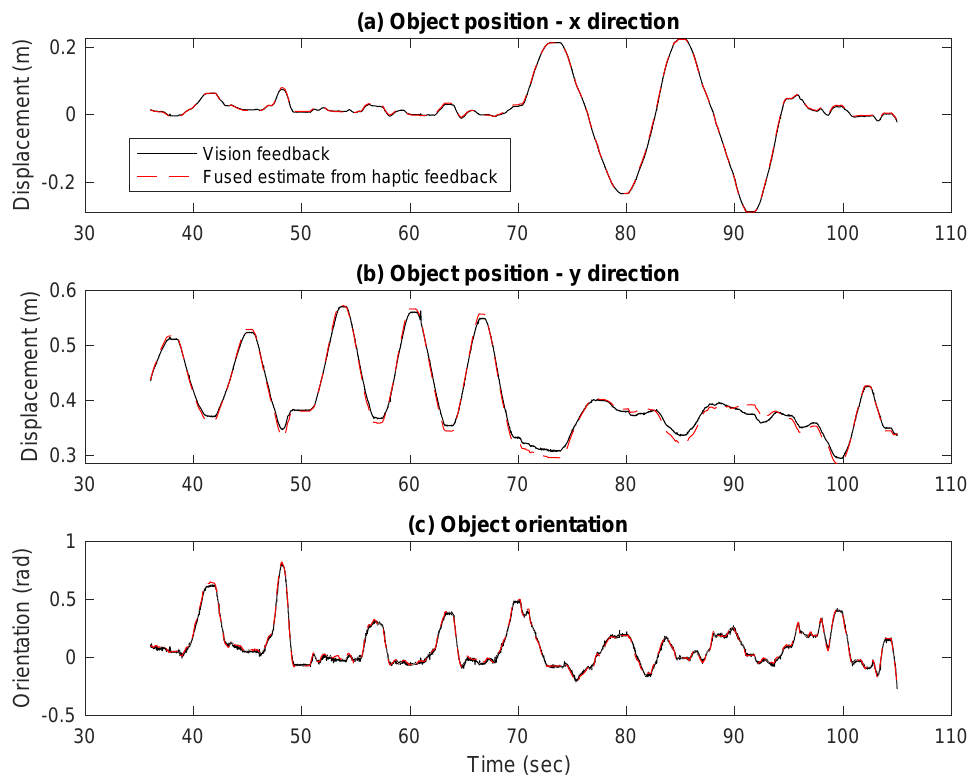
Figure 7. ( a ) Object position in x direction. ( b ) Object position in y direction. ( c ) Object orientation. All measurements are reported in frame { 0 }